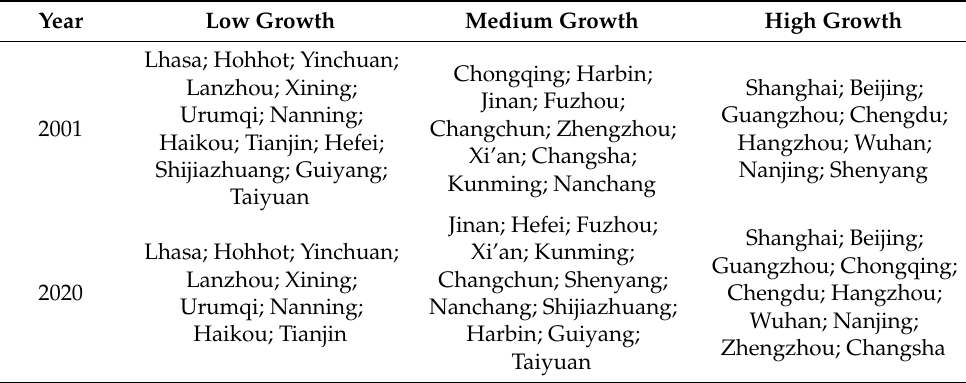
Table 4. Spatial evolution trend table of urban economic